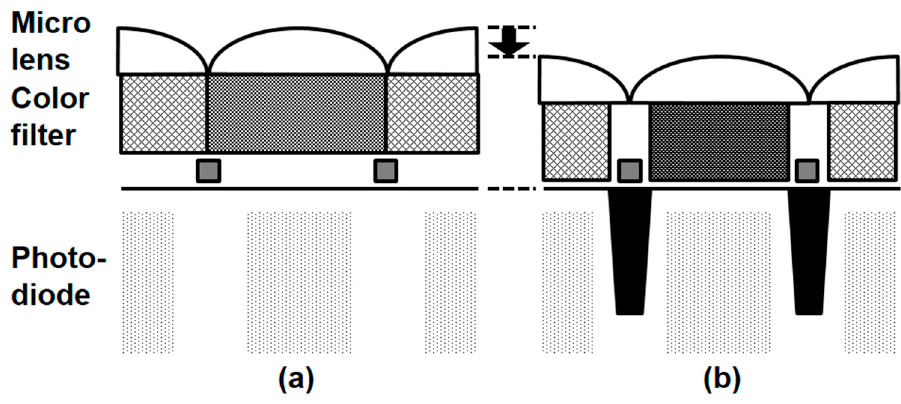
Figure 13. Schematic cross-sectional views of pixel. ( a ) Control pixel; ( b ) crosstalk-improved pixel.